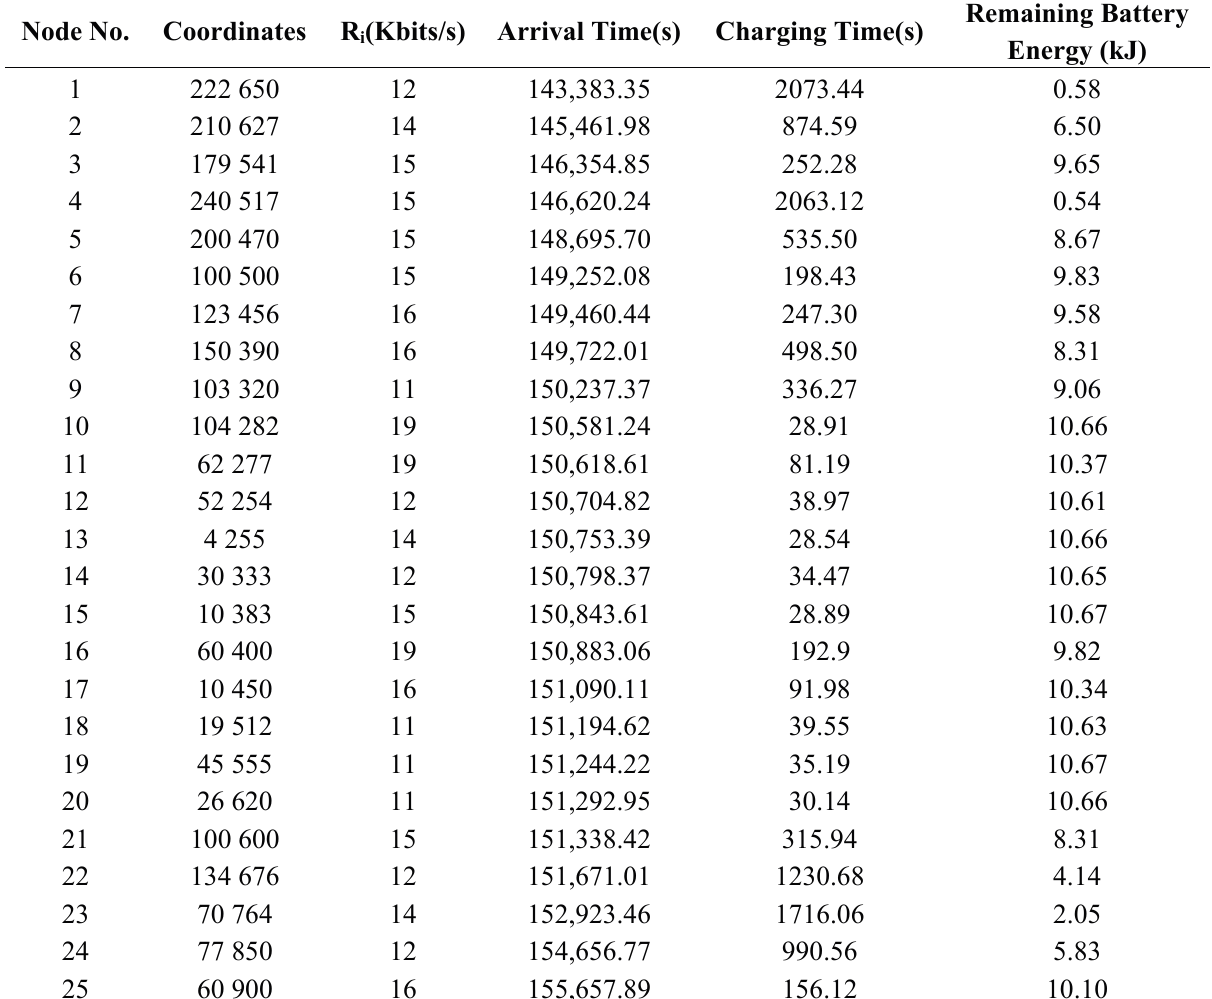
SN ; ( b ) The data routing schemes in 2 SN . 1